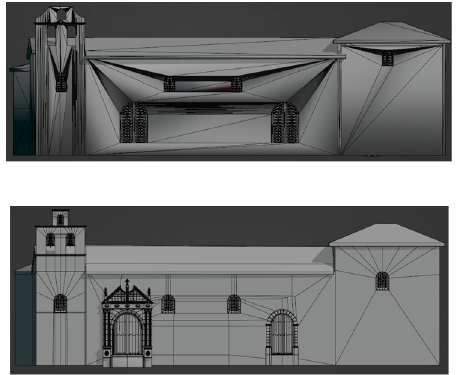
Figure 16. Optimization of building models.